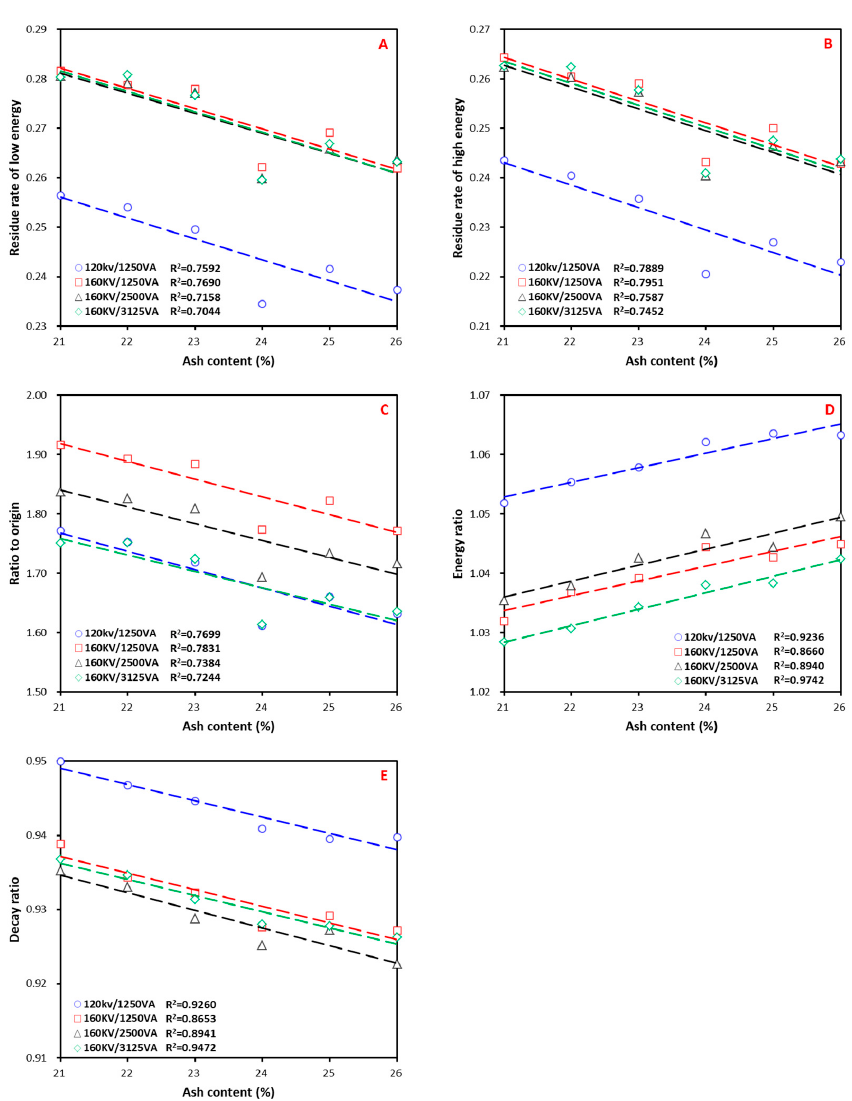
Figure 5. The relationship between ash content and characteristic parameters ( A ): residue rate of low energy; ( B ): residue rate of high energy; ( C ): ratio to origin; ( D ): energy ratio; ( E ): decay ratio at different tube voltages and tube currents.